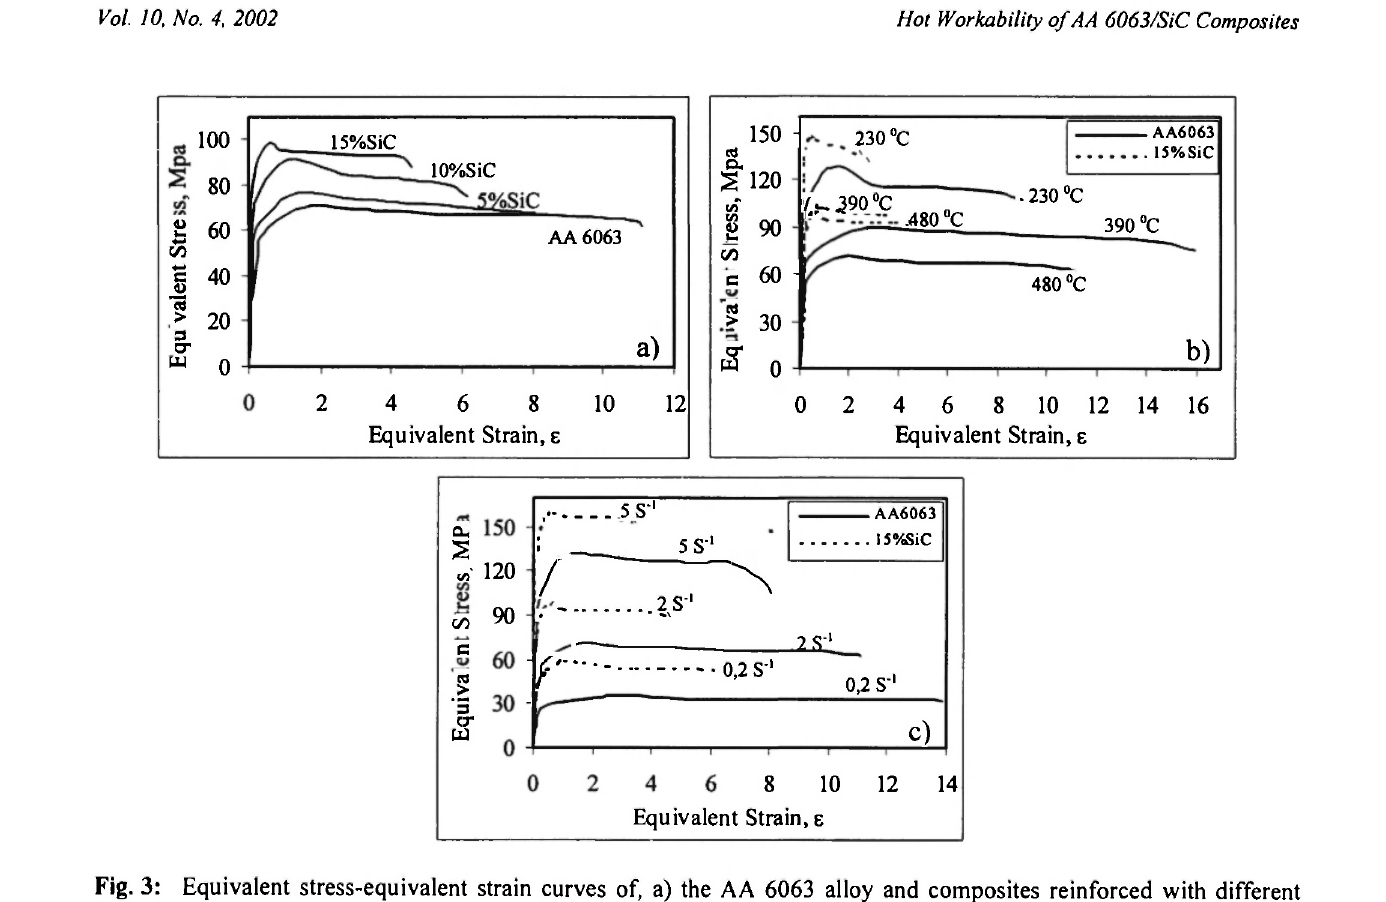
Fig. 3: Equivalent stress-equivalent strain curves of, a) the AA 6063 alloy and composites reinforced with different volume fractions of SiC deformed at 480°C for 2 s" 1 , b) and c) the AA 6063 alloy and AA 6063/15%SiC composite deformed at different deformation temperatures for 2 s 'and at different strain rates at 480°C,